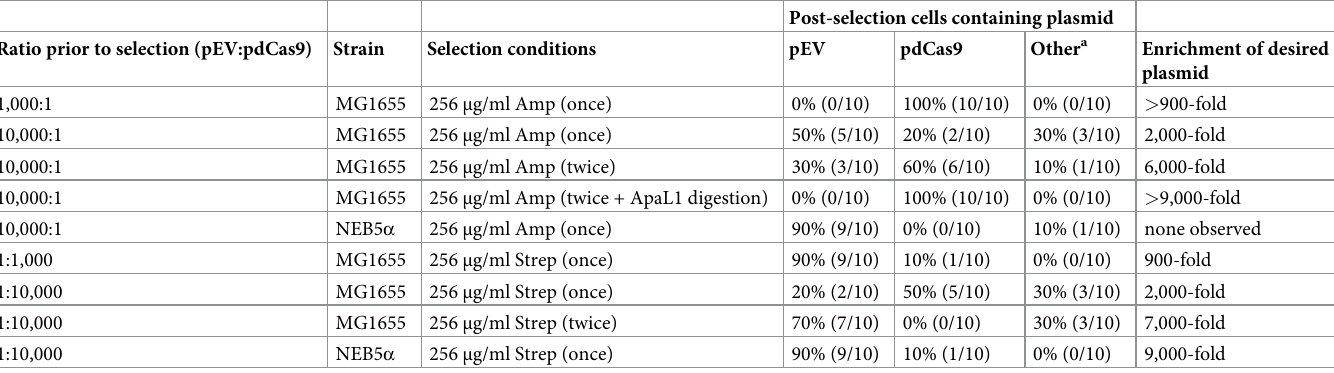
Table 1. Mock enrichment of active and inactive dCas9.